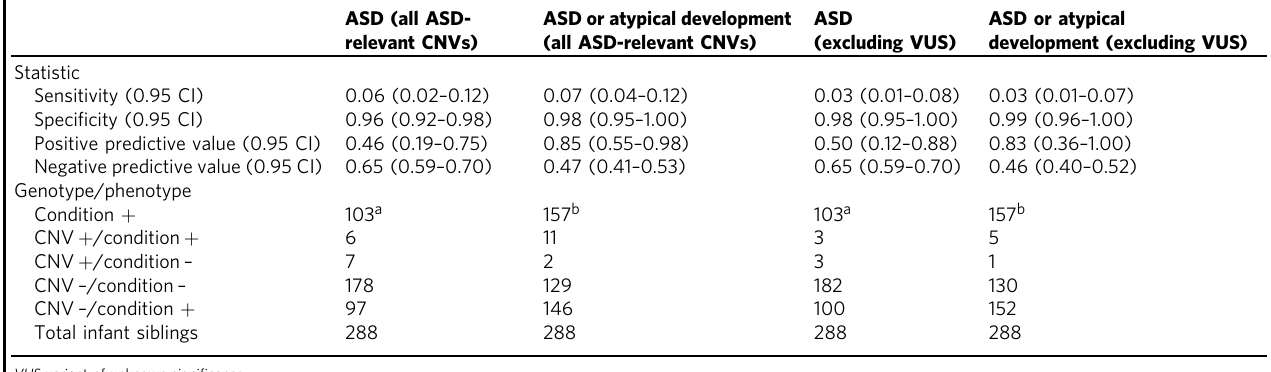
Table 1 Predictive statistics of microarray fi ndings in infant siblings of ASD probands.